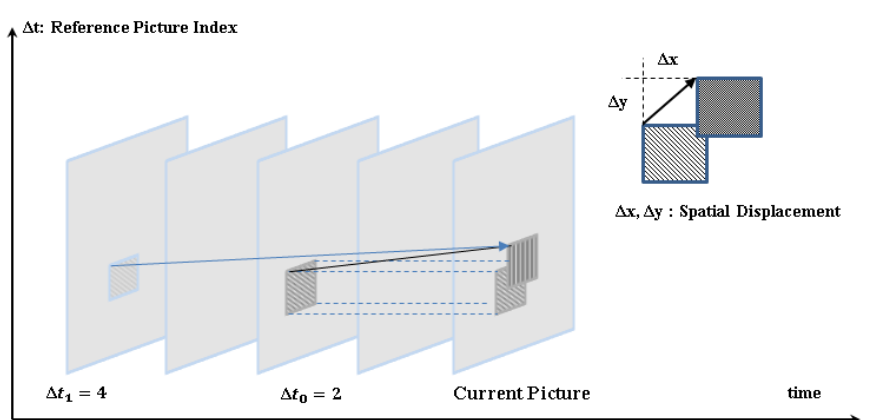
Figure 2. Reference motion vectors in video